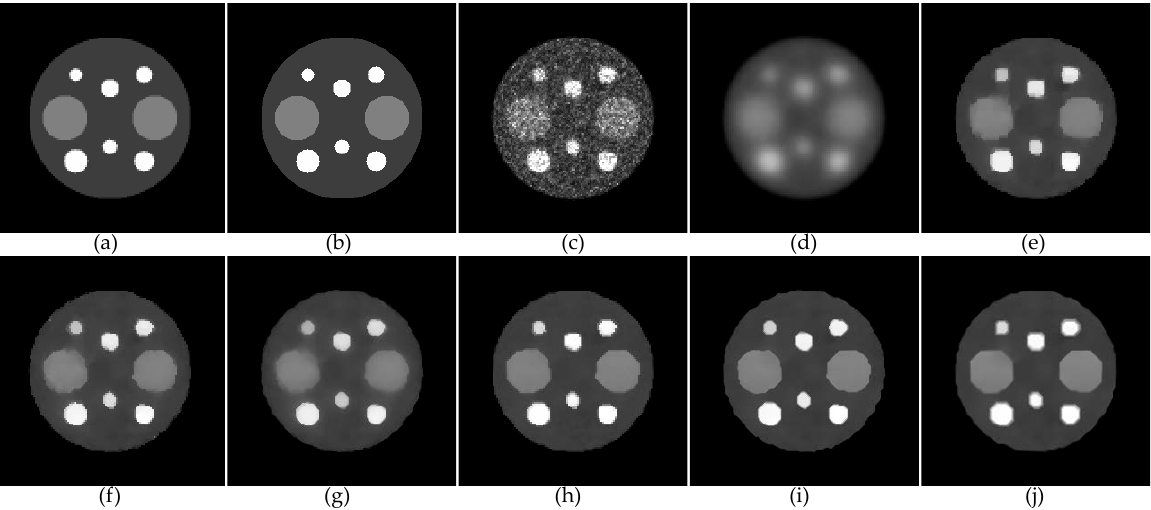
Figure 2. Anecdotal PL reconstructions: ( a ) LR phantom; ( b ) HR phantom; ( c ) LR-COSEM; ( d ) LR- LQR (MPE = 37.42%); ( e ) LR-LNQR (MPE = 19.27%); ( f ) LR-NWMR (MPE = 18.31%); ( g ) HR-NWMR (MPE = 18.89%); ( h ) LR-SDMR (MPE = 17.31%); ( i ) HR-SDMR (MPE = 15.77%); ( j ) HR-NLR (MPE = 16.85%).